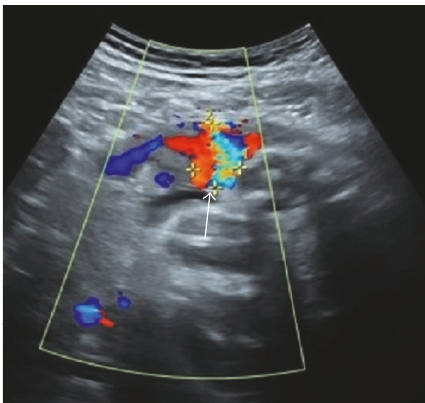
Figure 9: Final ultrasound image taken prior to delivery demon- strates persistence of the aneurysm, although it was significantly reduced in size to 2.0 cm